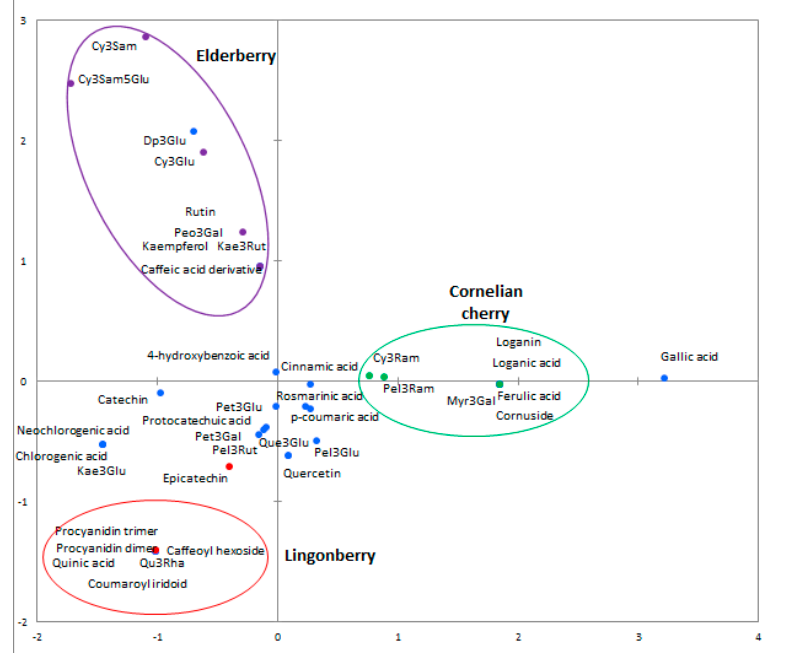
Figure 1. Principal component analysis (PCA) of chemical components identified using HPLC and LC-MS methods. The compounds characteristic for elderberry are marked in purple, lingonberry in red, and cornelian cherry in green. Blue markers correspond to compounds that are common to tested juices.